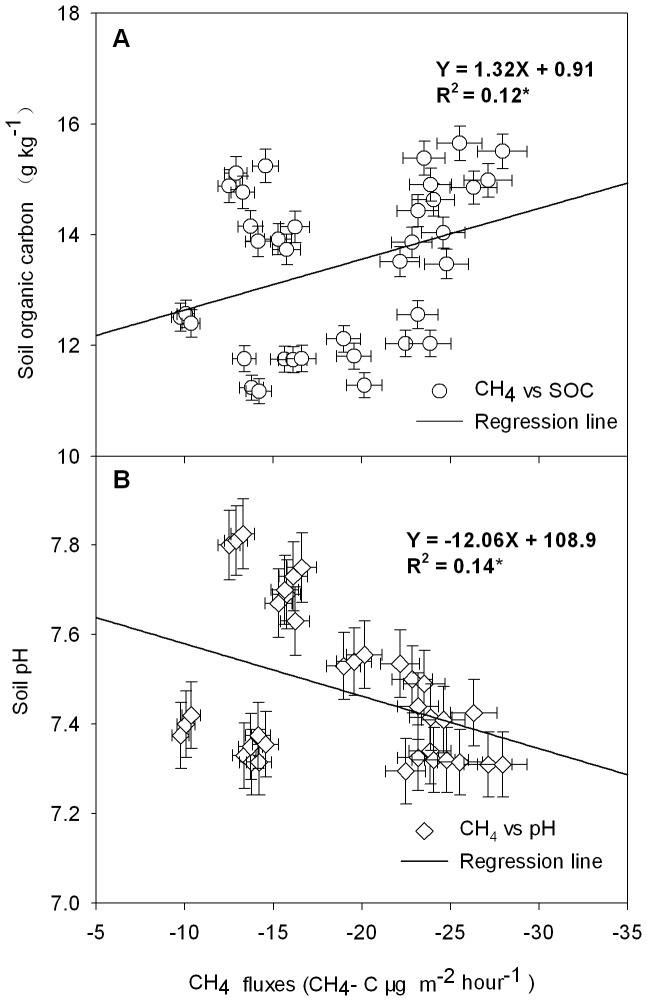
A Linear regression between the CH4 uptake fluxes and SOC, B Linear regression between the CH4 uptake fluxes and soil pH.Arrows indicate the regression equation between the CH4 uptake fluxes and soil organic carbon, soil pH. *indicates P<0.05.